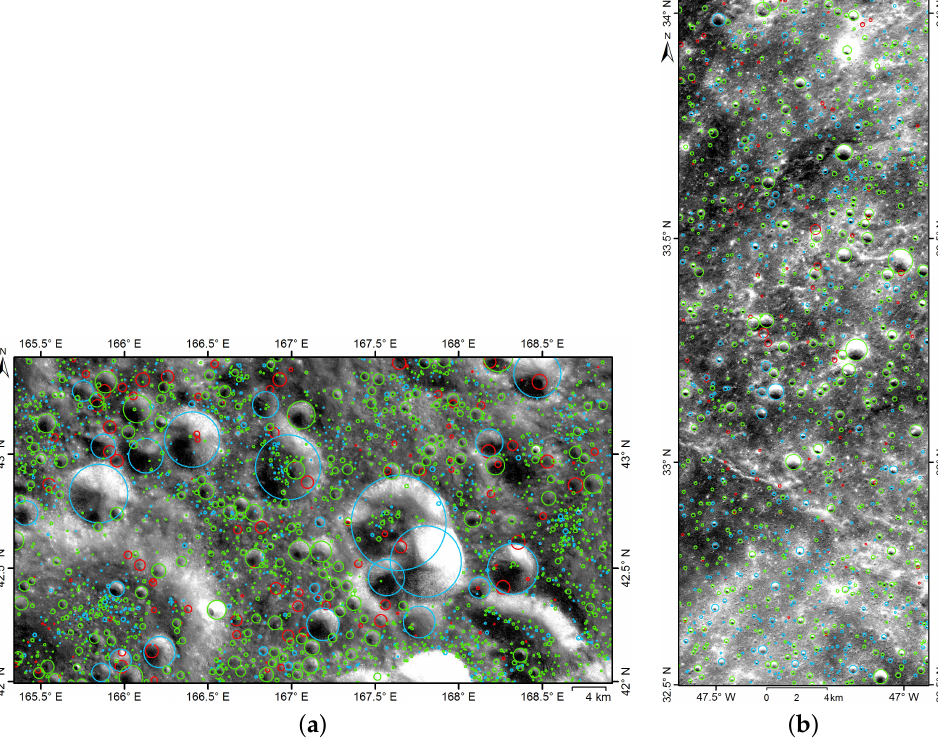
Figure 13. Distribution of craters detected by Crater R-CNN with TTSN in Highland ( a ) and Maria ( b ) regions: Green, true positives; red, false positives; blue, true